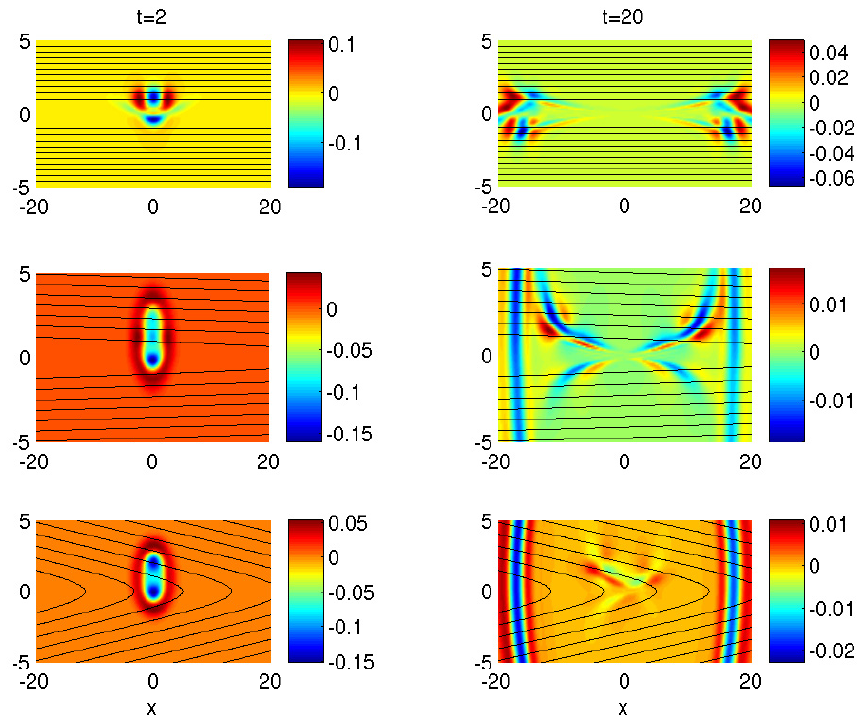
Fig. 7. Influence of a small B z component on the propagation of the eigenmodes of the plasma sheet. Thermal pressure p(x,z,t) is plotted in the x-z-plane for two values of time: t = 2 on the left column and t = 20 on the right column. From top to bottom the normal components is B z = 0 0.01 0.1 B ref . Background field lines are also displayed. While an eigenmode structure develops very quickly in the 1-D case it takes longer to develop with the presence of a B z . The higher the normal field is the slower is the propagation of the eigenmodes.